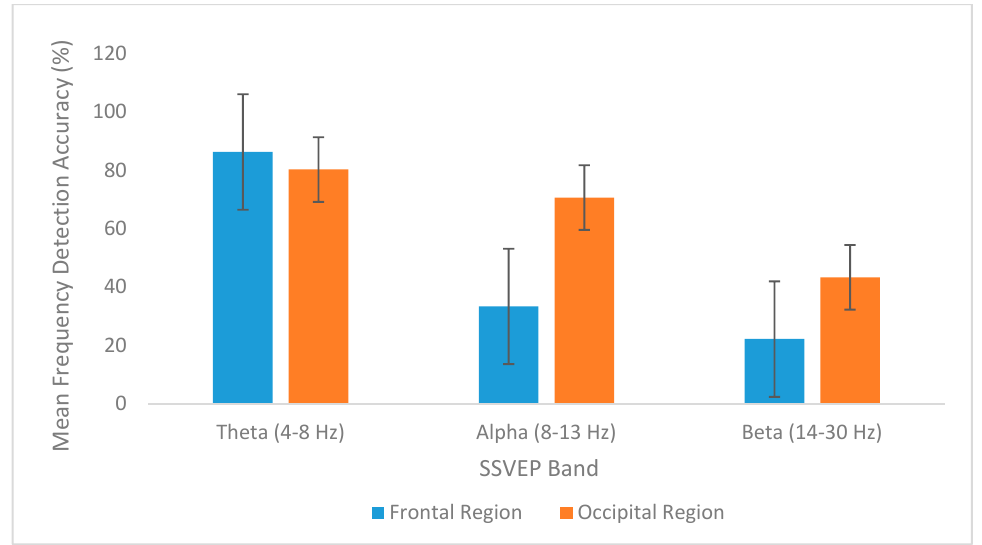
Figure 5. Mean detection accuracy of theta, alpha, and beta stimulus frequencies in frontal and occipital SSVEP signals.